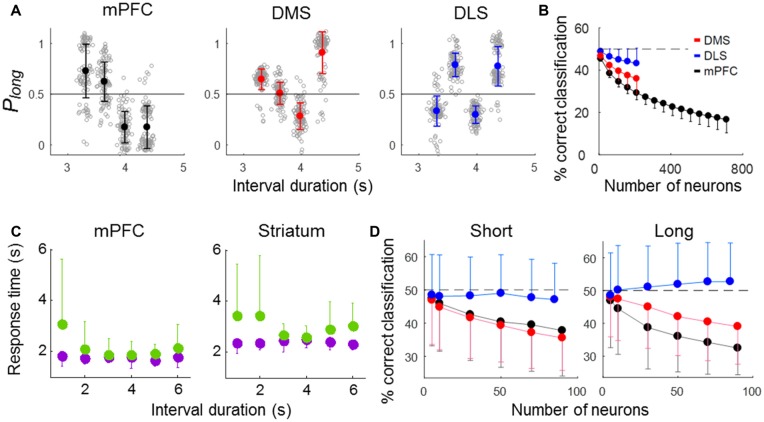
Results of error-trial analysis. (A,B) Classification of sample-interval length based on neuronal ensemble activity in error trials. Note that a linear discriminant function was generated using only correct trials. (A) Classification of sample-interval length based on all recorded units pooled across sessions. Neural classification was performed using 200 neurons that were selected randomly from each simultaneously recorded ensemble, and this was repeated 100 times. The same format as in Figure 5B. (B) Results of a neuron dropping analysis. The same format as in Figure 5C. (C) Mean reaction times in correct (purple) and error (green) trials for each sample interval duration. (D) Neural classification of sample-interval length for short and long reaction-time error trials (see text). Note that length classification and prediction of the animal’s duration judgment are inversely related in error trials. Error bars, SD.